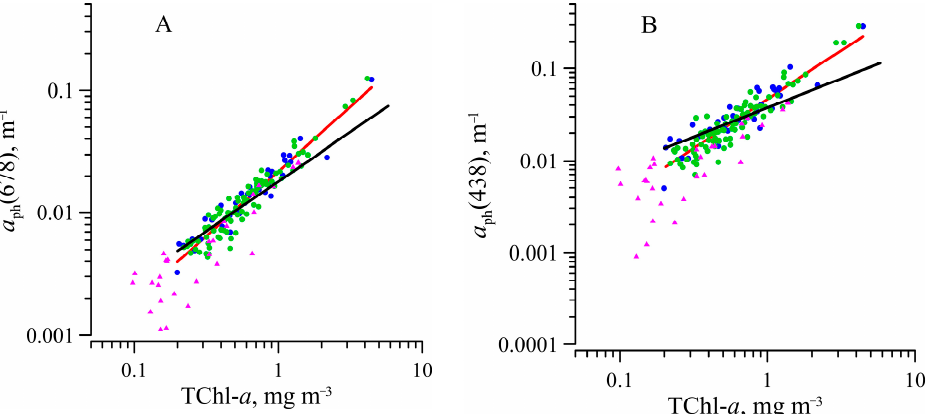
Figure 5. Variations of the light absorption coefficients of phytoplankton at 678 nm ( a ph ( 678 ) ) ( A ) and at 438 nm ( a ph ( 438 ) ) ( B ) as a function of the sum chlorophyll a and phaeopigments concentration (TChl- a ), for various water layers: surface—blue symbols; euphotic zone, but below 1 m depth—green symbols; layer below euphotic zone—purple symbols. The red and black lines are the regression lines corresponding to Equation (7) for our data in the euphotic zone and obtained by [50], respectively. Coefficients for the regression and the coefficients of determination (r 2 ) are shown in Table 1. Table 1. Coefficients, number of samples ( n ), and coefficient of determination (r 2 ) for the power